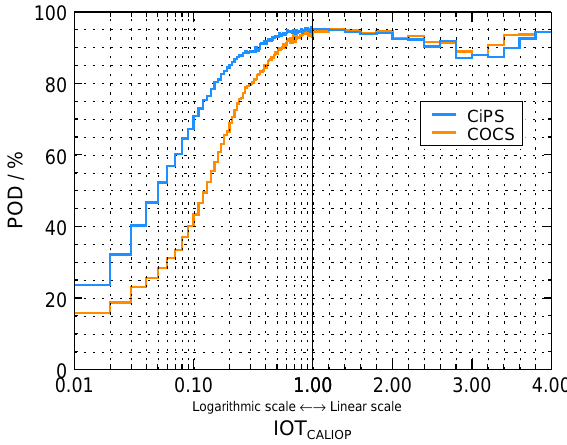
Figure 7. The POD of CiPS and COCS as a function of the IOT retrieved by